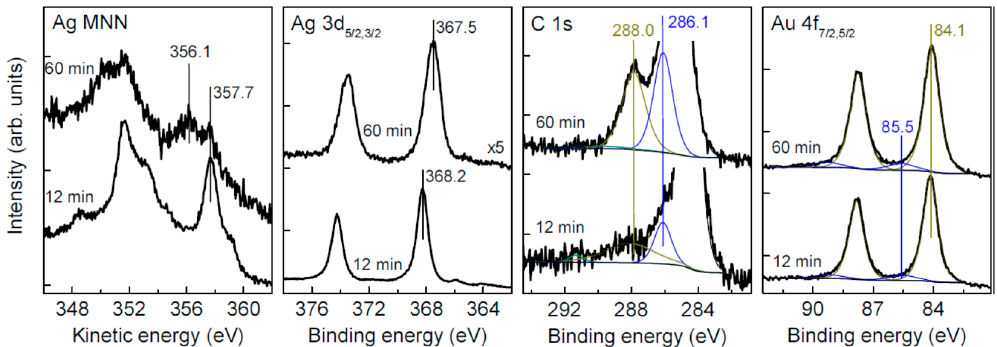
Figure 6. Ag NPs films treated with 4 mM HAuCl 4 aqueous solution for 12 and 60 min.